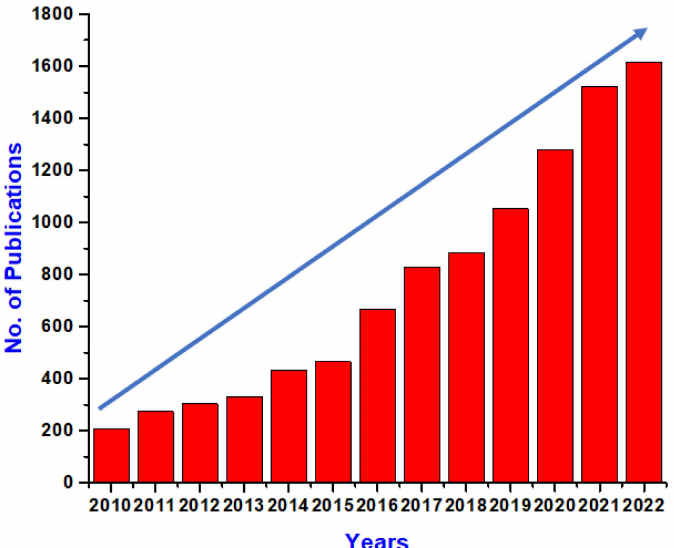
Figure 1. Publication trends (from 2010 to 2022) on the role of nanotechnology in cosmetics.